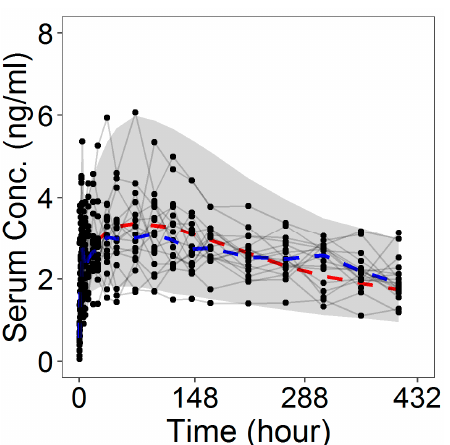
Figure 13. External VPC plot at 375 mg dose level. Simulations of progesterone serum concentra- tions at dose level 375 mg performed by the IVIVC P-ring model identified on data relative to doses 125, 750, and 1500 mg. The 90% confidence interval (grey area) is shown together with the observed data (black dots); dashed lines represent the theoretical (red) and experimental (blue) median.